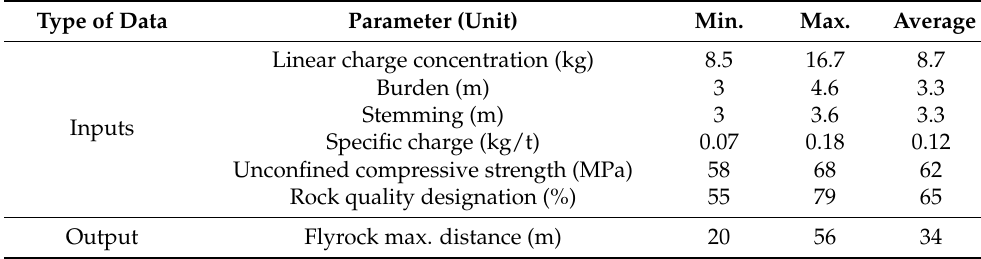
Table 5. The input and output parameters used in ANN [73].